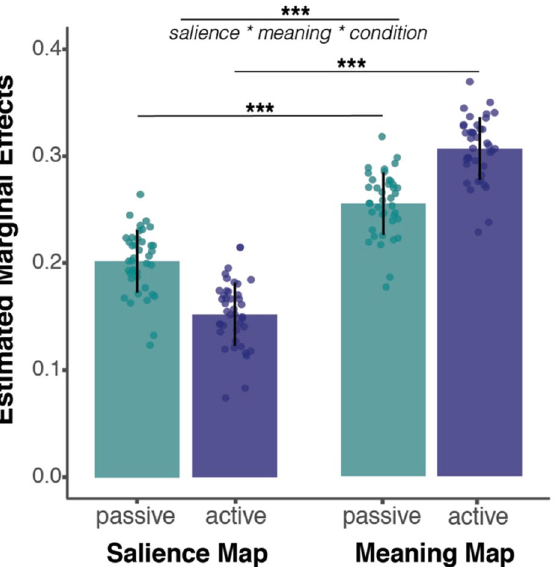
Figure 3. Active viewing increases top-down attentional allocation. Estimated marginal effects of salience and meaning maps on predicting overt attention in each condition (active vs. passive). We found that viewing condition (active vs. passive) significantly modulated gaze behavior (salience*meaning*condition: p < 0.001). Specifically, active viewers disproportionately directed their attention to meaningful, over salient, scene regions. Individual points represent random item effects (i.e., individual scenes). Error bars represent prediction intervals (± 1 STE). *** denotes p <